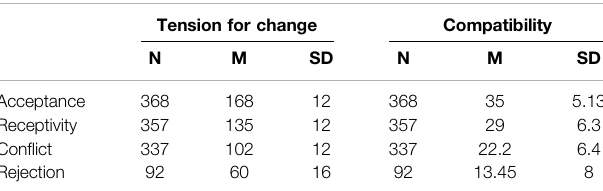
TABLE 3 | Implementation climate